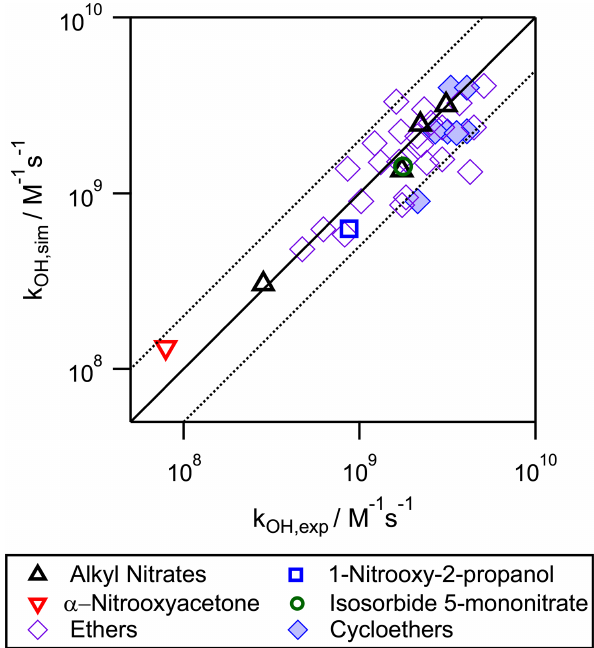
Figure 6. Correlation plot between the experimental and the sim- (cid:113) ulated aqueous-phase OH-oxidation rate constants for organic ni- trates and ethers. The solid line corresponds to the 1 : 1 regression, and the dotted lines represent the limits where the simulated rate constants deviate from the experimental ones by a factor of